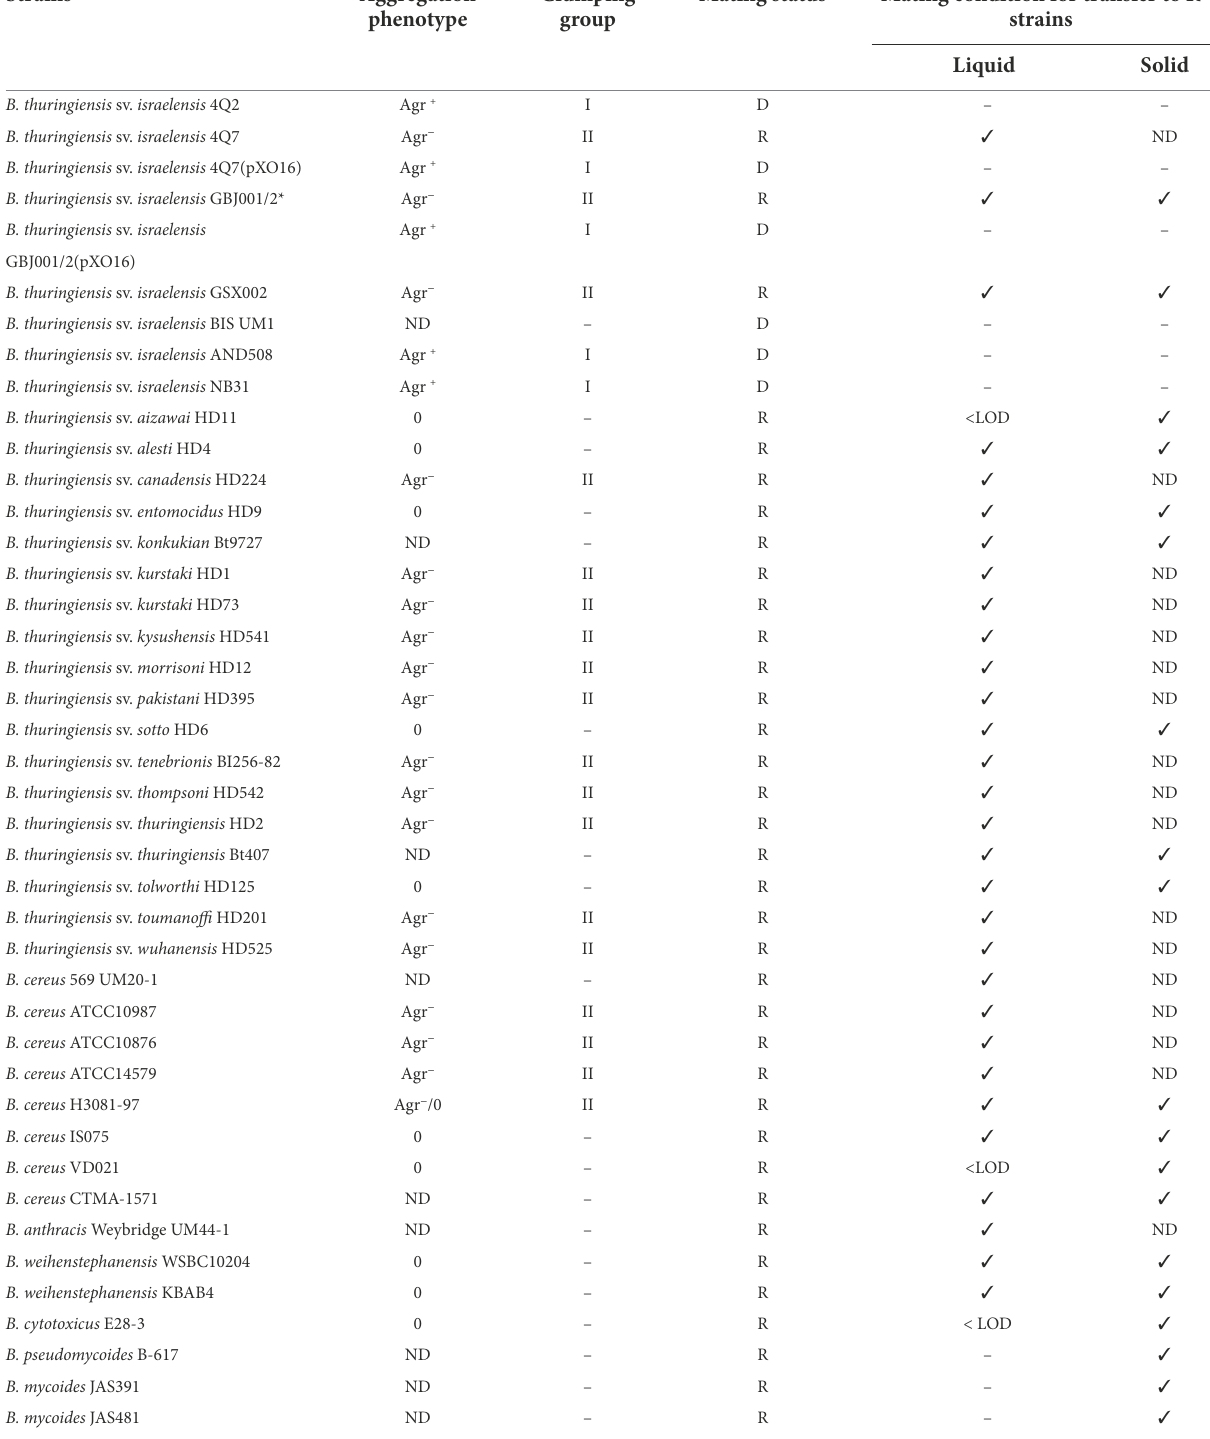
TABLE 2 pXO16 host spectrum. List of all the strains to which pXO16 transfer was successfully demonstrated under liquid or solid mating conditions, either by assessing the aggregation phenotype of the strain or by plating out transconjugants. This table also contains strains in which pXO16 was naturally found and that were used as donors in mating experiments. When appropriate, the aggregation phenotype/clumping status of the strain is mentioned. Original data can be found in the followings: Reddy et al. (1987); Andrup et al. (1993); Jensen et al. (1995, 1996); Makart et al. (2018); Hinnekens et al. (2019, 2021); Hinnekens and Mahillon